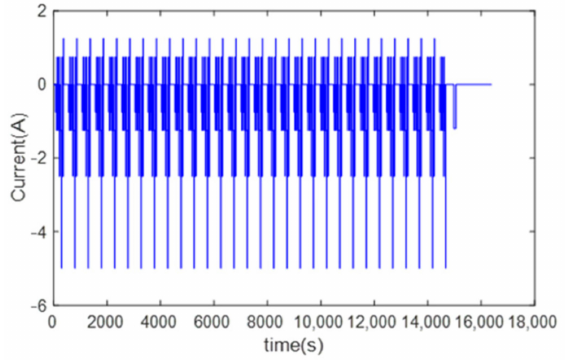
Figure 16. Current waveform of DST working condition.